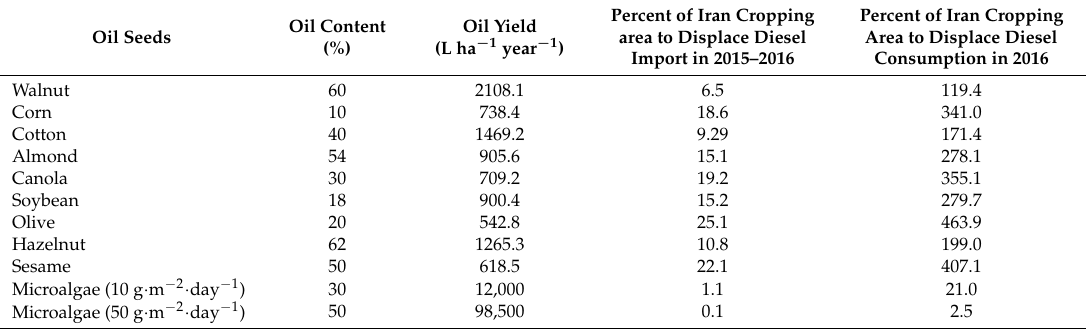
Table 5. Comparison of the biodiesel production potential of oil seeds and microalgae to displace diesel in